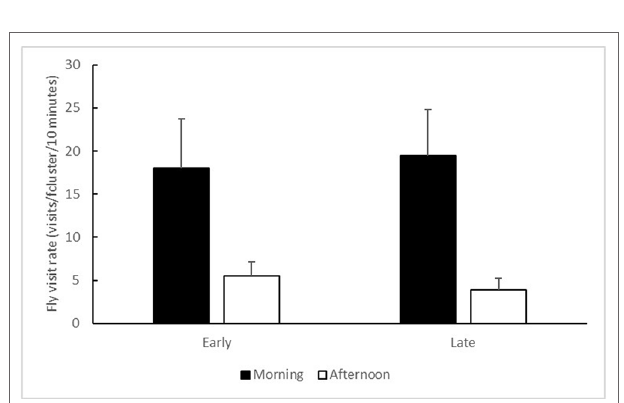
FIGURE 5 | Mean (+ SE) numbers of fly visits per flower cluster over a 10-min observation period, conducted in the morning (black bars) and in the afternoon (white bars). Data from the Tabor Stream and the Shoket populations were combined, because 78.9% of all visits occurred at the Tabor Stream site.